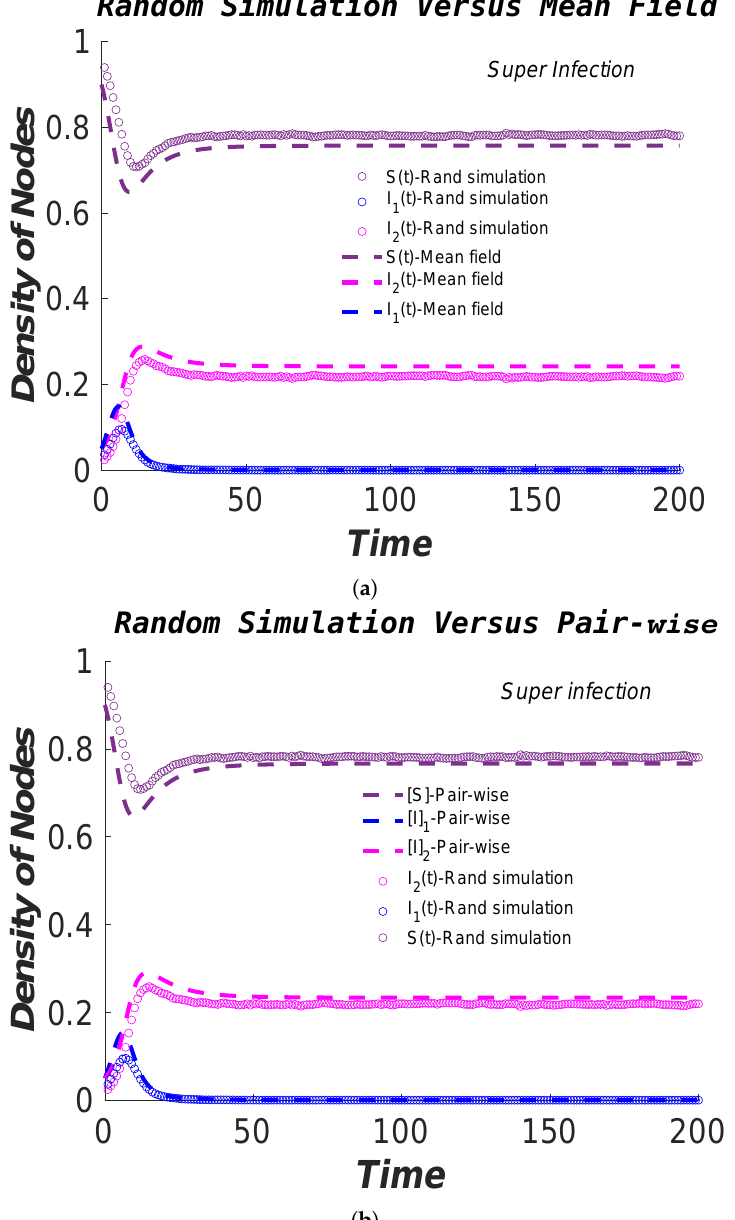
Figure 9. Comparison of random simulation with mean-field and pairwise models for super-infection, in ER network: γ 1 = 0.6, γ 2 = 0.4, λ 1 = 0.36, λ 2 = 0.24, and λ 3 = 0.8. ( a ) Comparison of random simulation and mean-field model. ( b ) Comparison of random simulation and pairwise